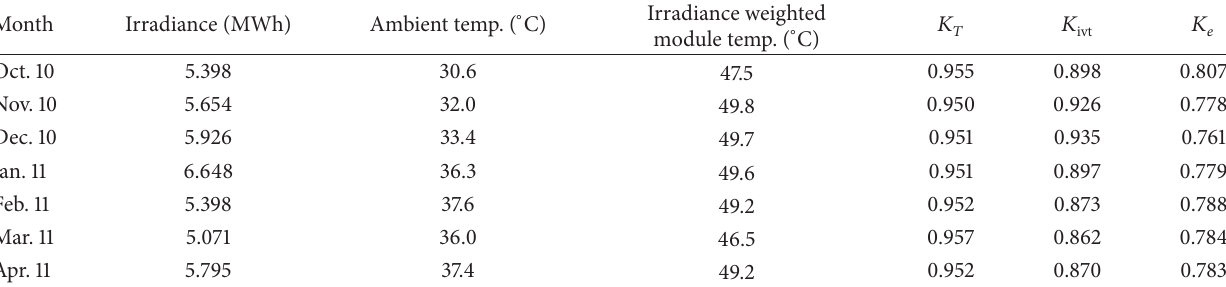
Table 3: The monthly basis of irradiance, average ambient temperature, average module temperature, and correction coefficients. Month Irradiance